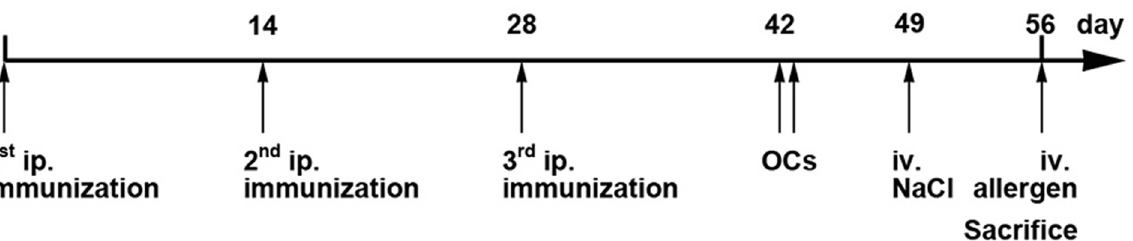
Fig 1. Immunization protocol. Mice were immunized i.p. with untreated BLG (n = 15) or OVM (n = 15) three times, followed by two oral challenges (OCs) on days 42 and 43. Subsequently, mice were divided in three groups per allergen (n = 5) and challenged i.v. with vehicle control on day 49 followed by i.v allergen challenges on day of sacrifice. Blood samples were collected on days 42, 49 and 56. BLG, beta-lactoglobulin; i.v., intravenous; OC, oral challenge; OVM,